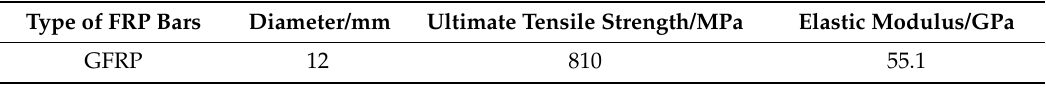
Table 1. Mechanical properties of glass fiber-reinforced polymer (GFRP)